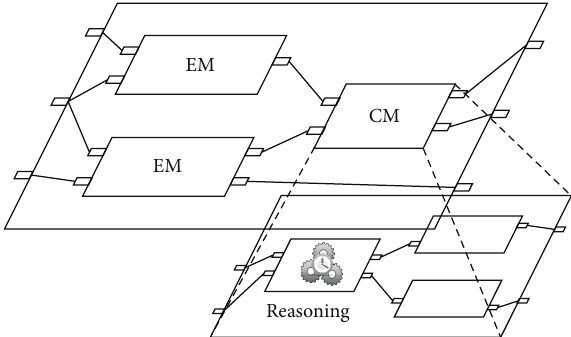
Figure 2: A simulation system integrated by qualitative and quanti- tative models.